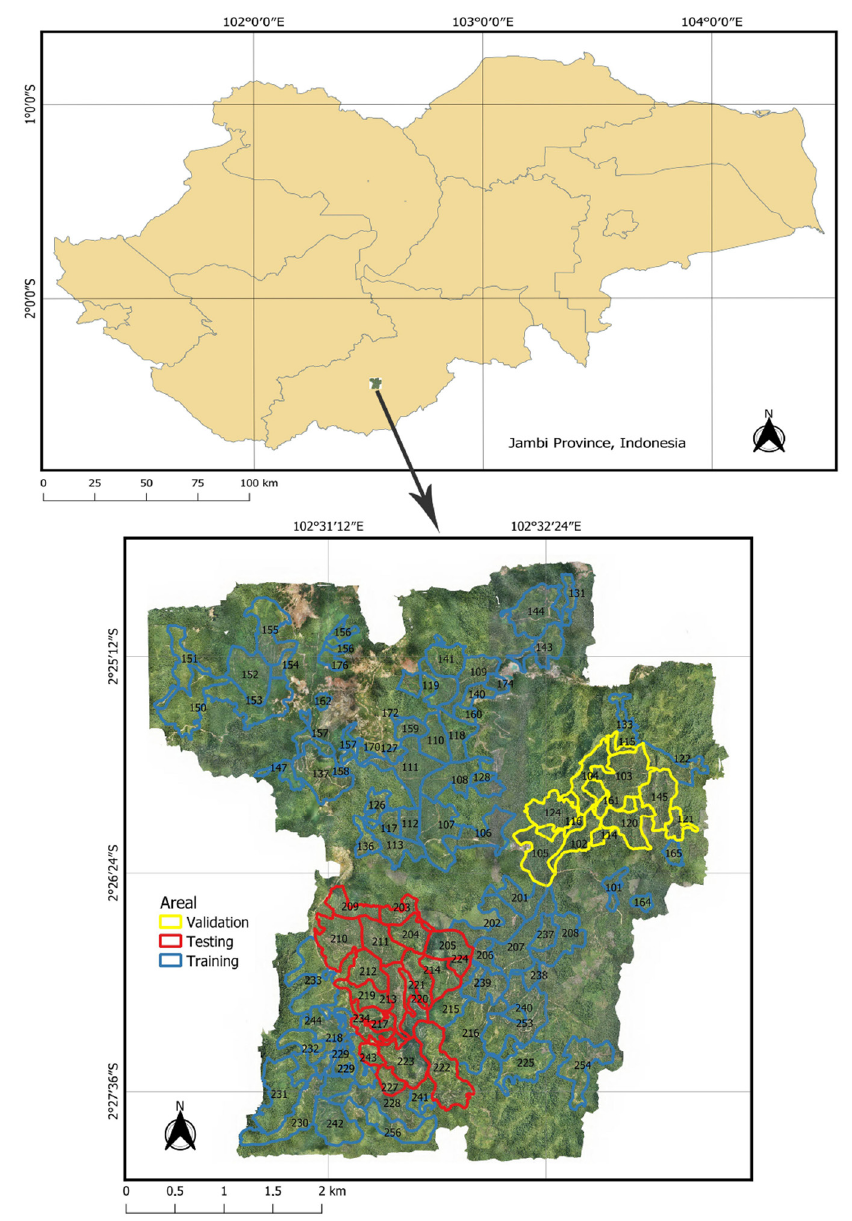
Figure 2. The study area is located in Jambi province, Indonesia. The drone images of oil palm plantations consist of three areas. Blue and yellow polygons are for training and validation areas, while red polygons are for testing areas.